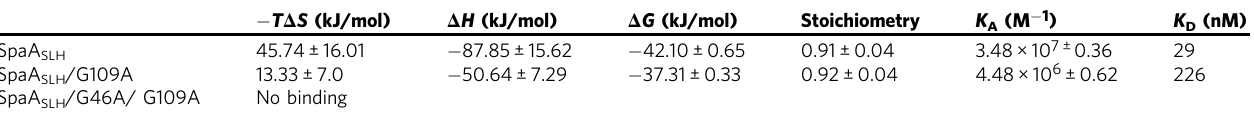
Table 1 ITC analyses of 4,6-Pyr- β - D -ManNAcOMe